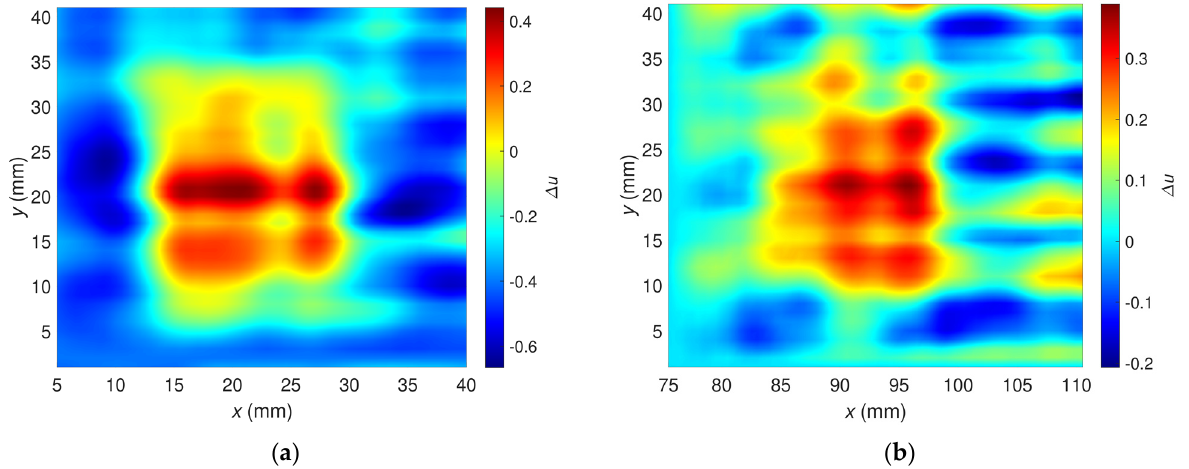
Figure 14. Two-dimensional plot of the relative voltage after background signal removal; excitation frequency f = 2 MHz; plot for the flaw: ( a ) OF70%, ( b ) OF30%.